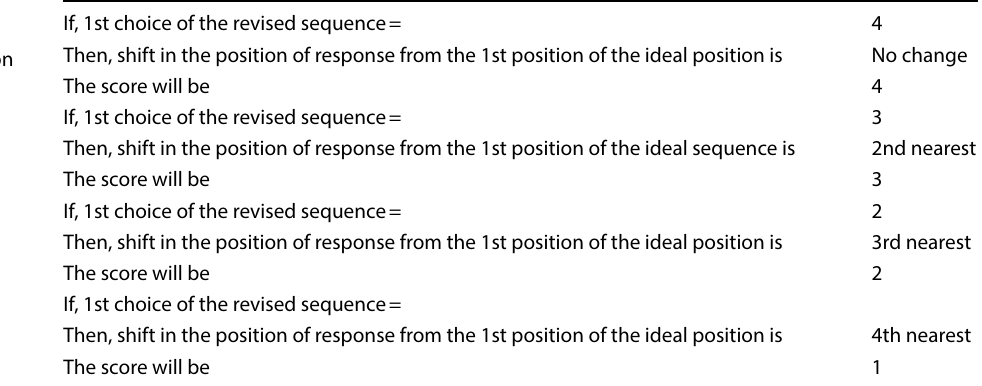
Table 4 Response Score for shift in the position of response from the 1st position of the ideal